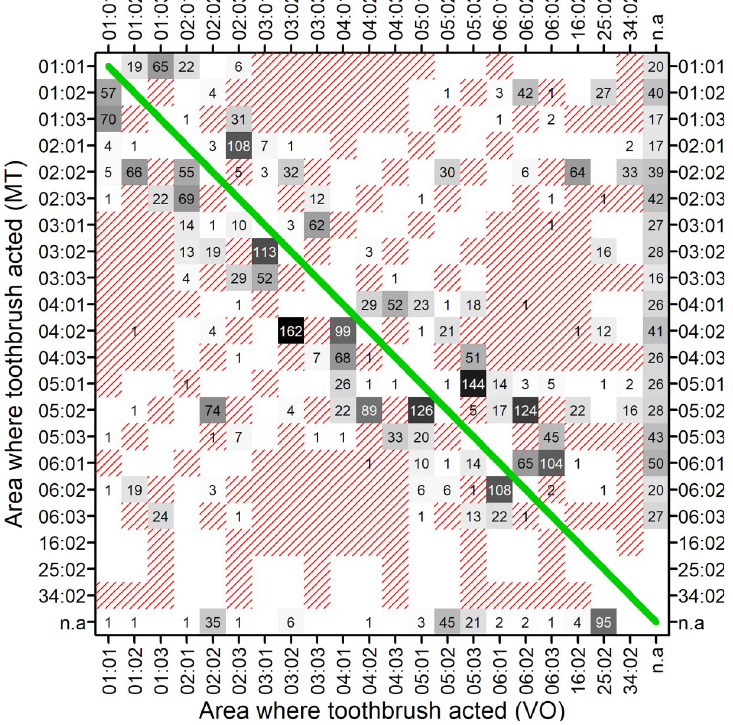
Fig 2. Heat map of confusion matrix based on first part of the study. The first pair of digits on the axes is the sextant (01–06; 16, 25 34 = subjects brushed opposing lateral right, frontal and lateral left sextants simultaneously with closed jaws), the second pair of digits is the surface (01 = occlusal/incisal, 02 = vestibular, 03 = oral). Correct classifications indicated by the diagonal line are excluded. Numbers and corresponding grey-shading indicate total numbers of mismatches out of the total of 22757 intervals considered (omitted if no respective mismatches, i.e. if equal to 0). Red- shaded areas indicate non-adjacent (i.e. more problematic) confusions, e.g. opposite sides of the mouth or vestibular vs. oral